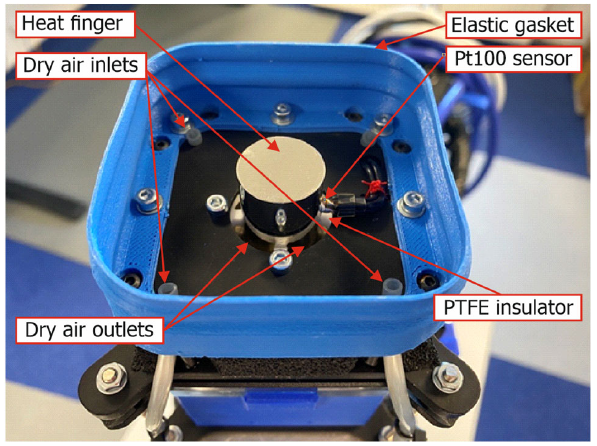
Figure 8. Elastic dry ‐ box gasket and the dry air inlets/outlets at the head. Dry air is supplied by the industrial compressed dry ‐ air installation. An Atlas ‐ Copco SF1P scroll oil ‐ free compressor feeds the air via the water separator and an adsorption dryer, Beko AC122 (allowing − 70 °C dew point at 6 bar), to finally reach the compressed air reservoir. The dry air is then distributed to the end units through the pressure regula ‐